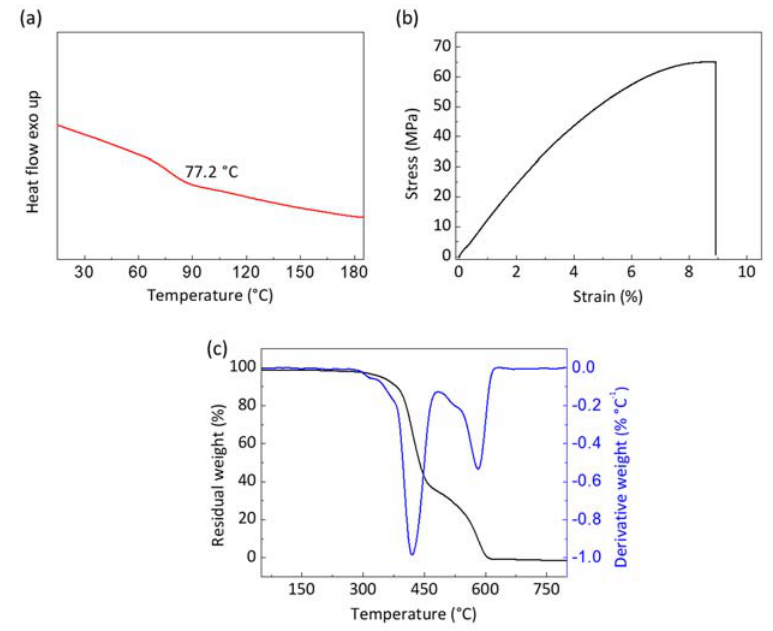
Figure A1. The mechanical and thermal properties of epoxy vitrimer. ( a ) DSC curve, ( b ) Stress–strain curve, ( c ) TGA and DTG curves. Table A1. Thermal and mechanical properties of the cured epoxy vitrimer.